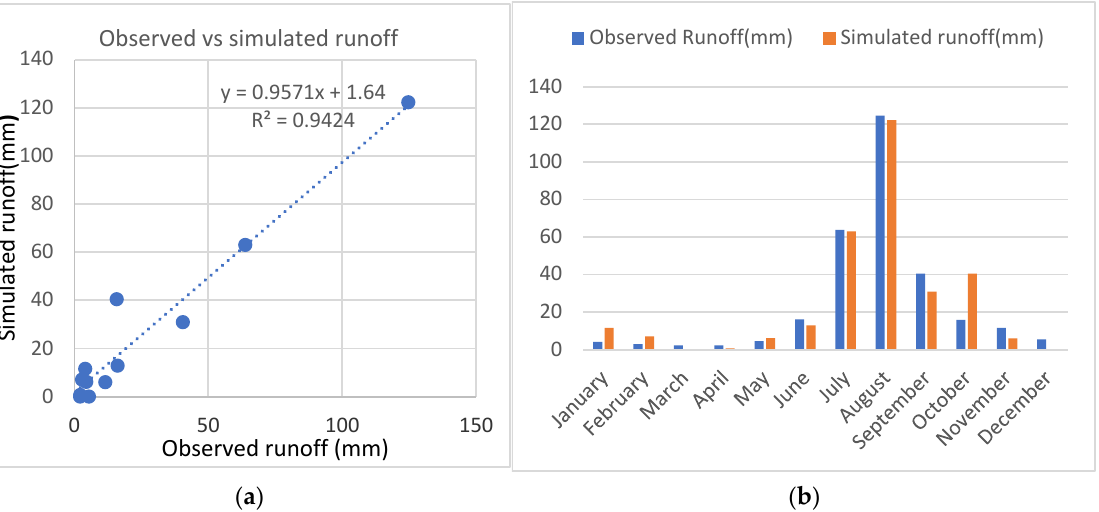
Figure 5. Runoff calibration period (2000–2002). ( a ) Observed versus simulated runoff; ( b ) Mean monthly runoff depth.